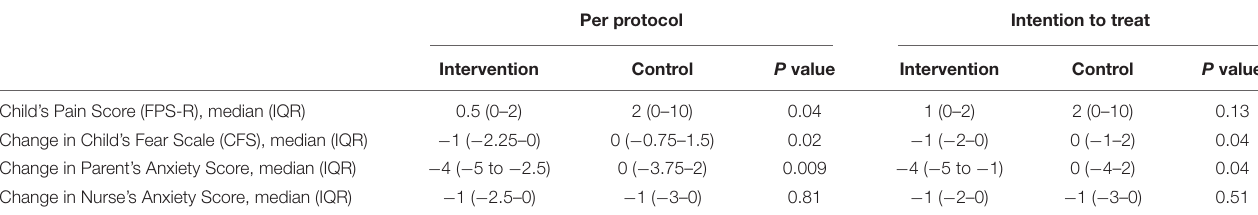
TABLE 2 | The children’s pain score, the change in the children’s fear scores, nurse’s and parental anxiety scores in the intervention and control groups. Per protocol